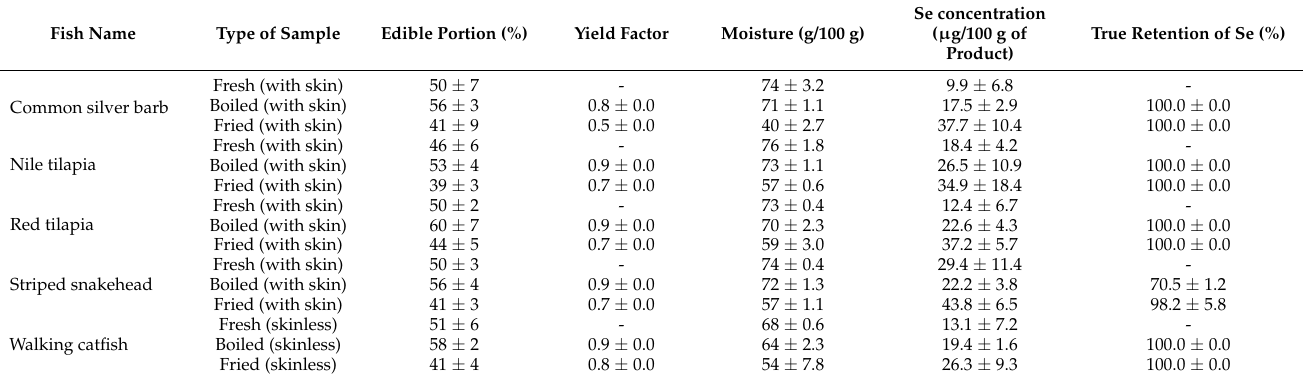
Table 3. Percentage of edible portion, yield factor, and moisture content of three individual sets from each type of freshwater fish, data expressed as mean ± SD ( n = 3).